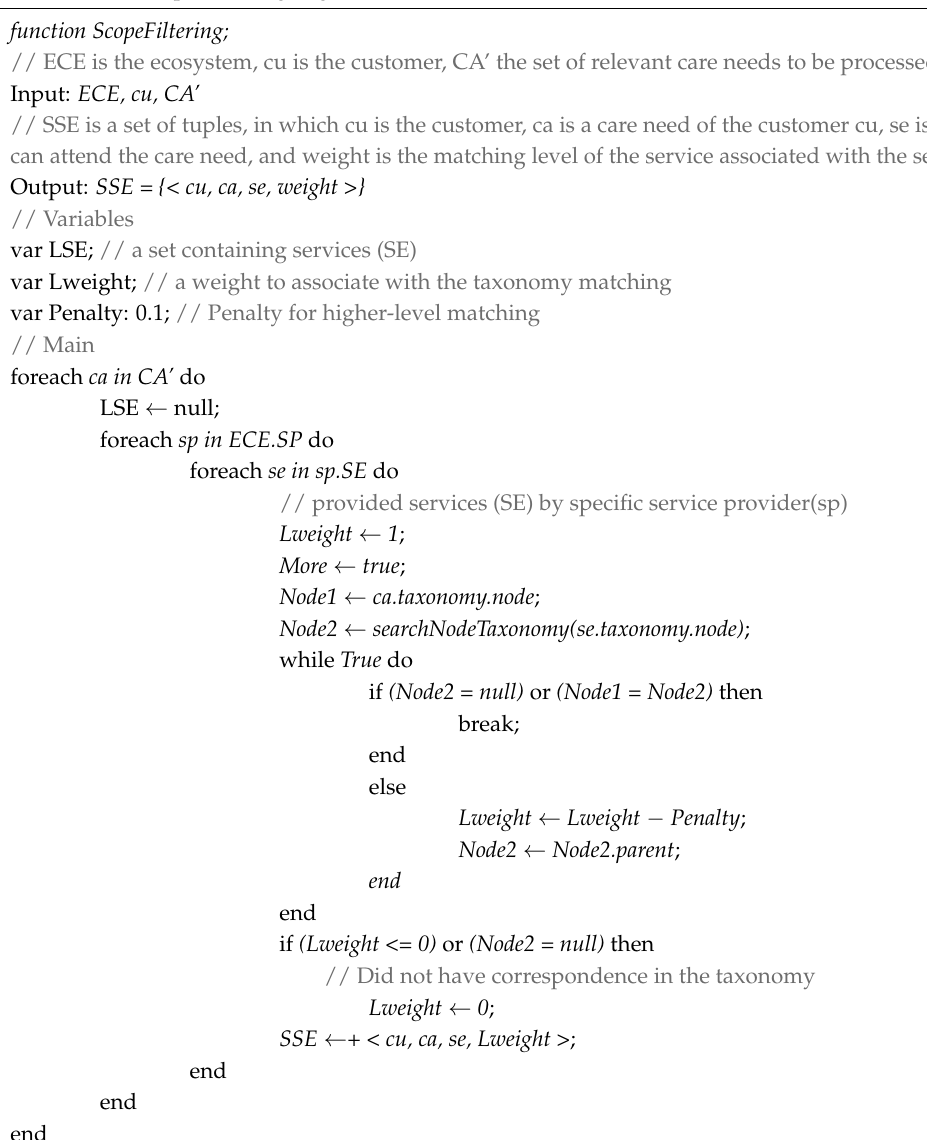
Algorithm 1 Scope Filtering